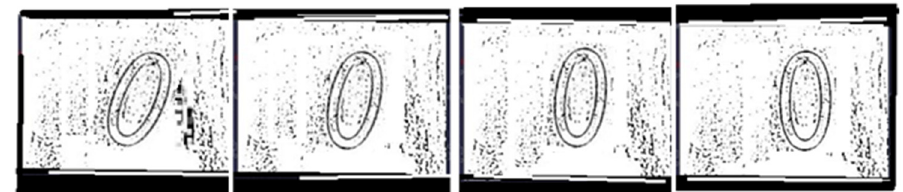
Figure A3. Application of the rotated segments algorithm to improve image quality.